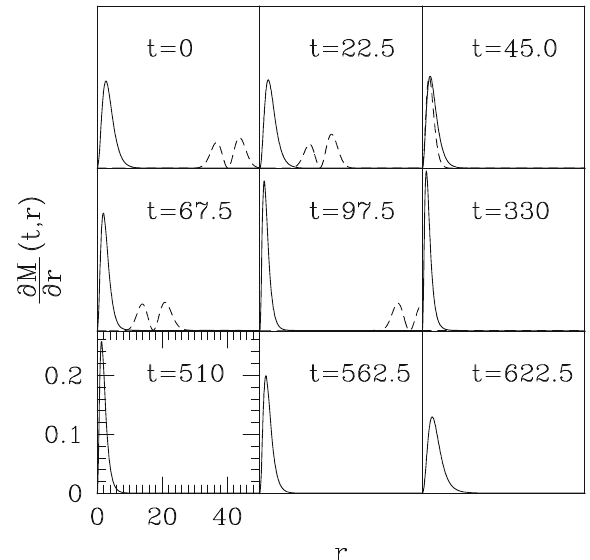
Fig. 24 Evolution of a boson star (solid line) perturbed by a shell of scalar field (dashed line). Shown is the mass density ∂ M /∂ r for each contribution. By t ≈ 100 the real scalar field pulse has departed the central region and perturbed the boson star into an unstable, compact configuration. Contrast the t = 0 frame with that of t = 97 . 5 and note the increase in compaction. This unstable BS survives until t ≈ 500 only because the initial perturbation has been tuned to one part in 10 15 and indicates Type I critical behavior. Reprinted with permission from Lai and Choptuik